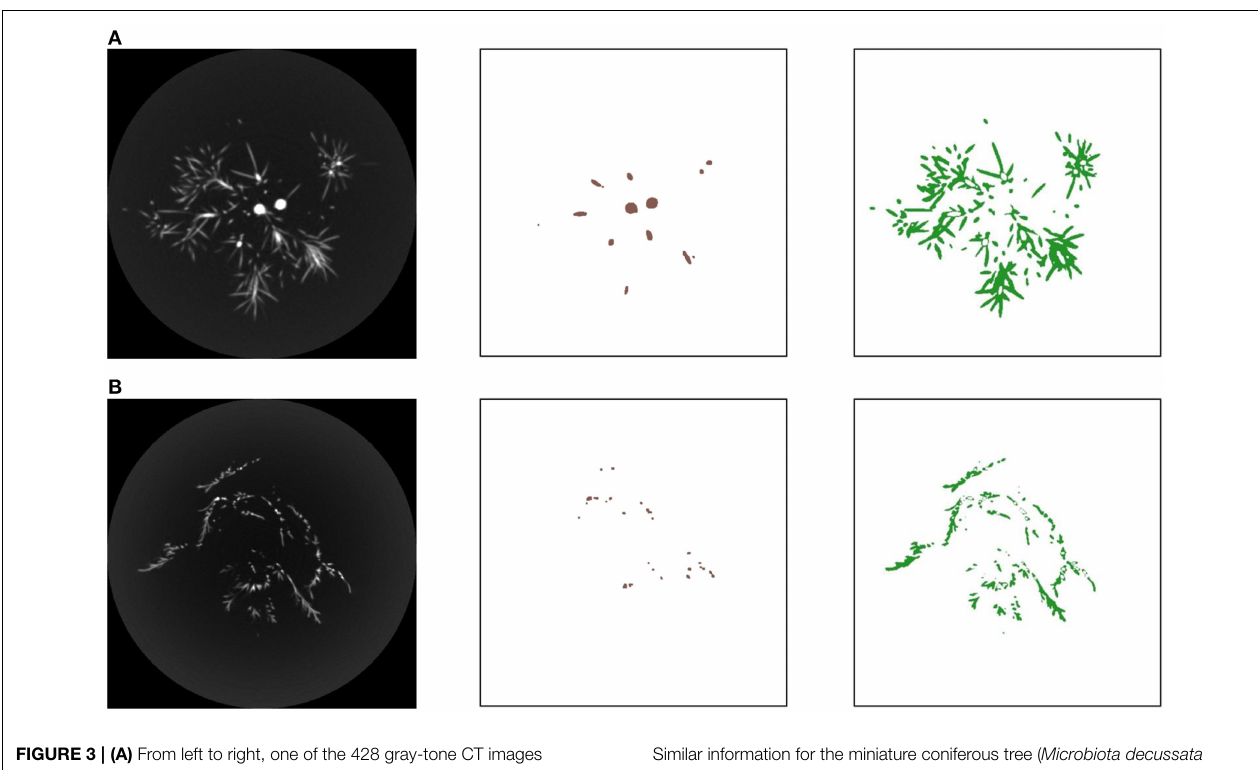
Similar information for the miniature coniferous tree ( Microbiota decussata Gold Spot) depicted in part in Figure 1B ; the gray-tone CT image displayed is one out of 450 with thickness of 0.3mm used to analyze the crown in this case. Note: The two skeletal branching patterns are contained in 400 and 438 CT images,